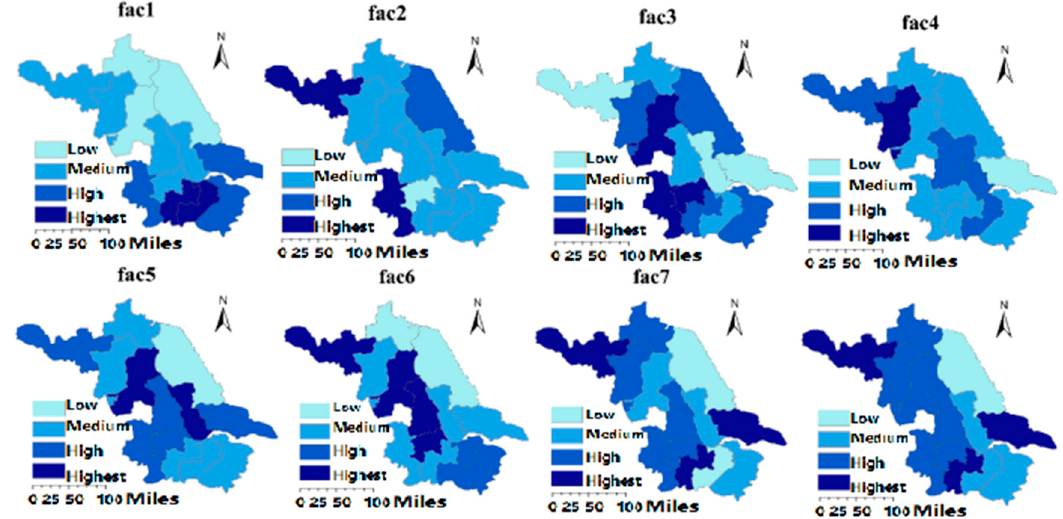
Figure 7. Spatial distribution of eight principal component